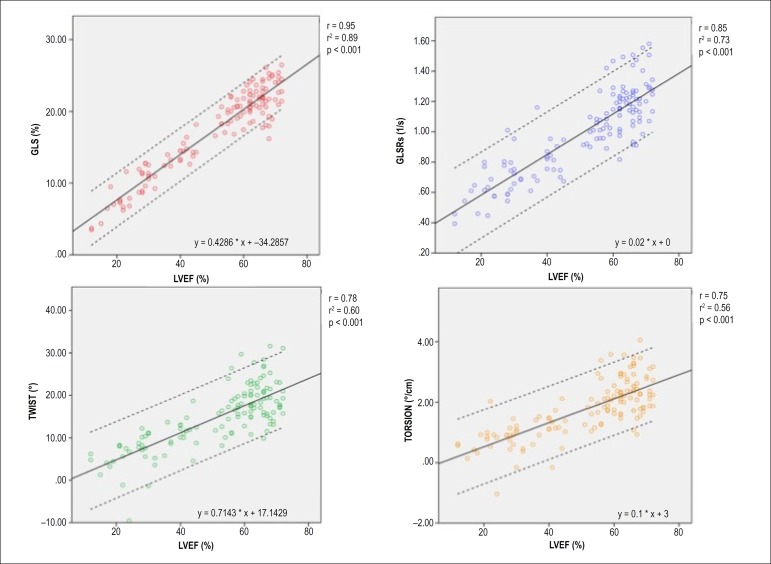
Correlation of different LV contraction parameters with LVEF (p <
0.001 for all correlations). GLS and GLSRs are displayed in absolute
values. LVEF: left ventricle ejection fraction; GLS: global longitudinal
strain; GLSRs: systolic global longitudinal strain rate.